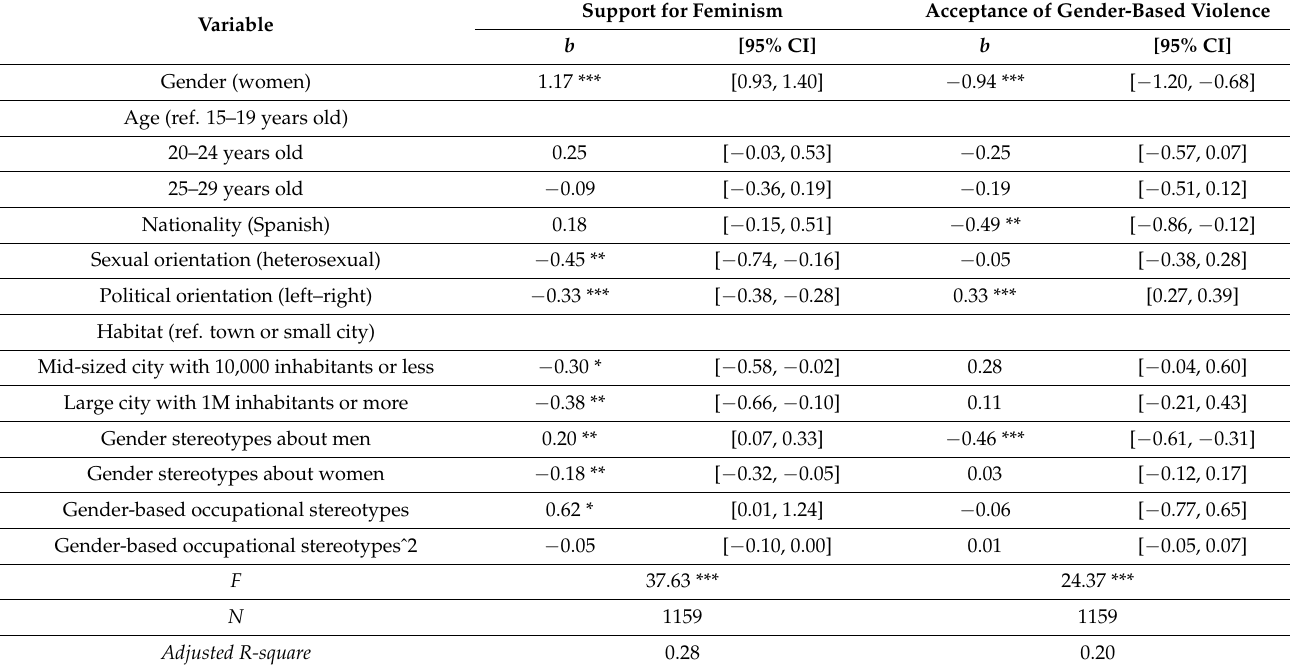
Table A4. Correlates of support for feminism and acceptance of gender-based violence (multiple linear regression models with a polynomial term for gender-based occupational